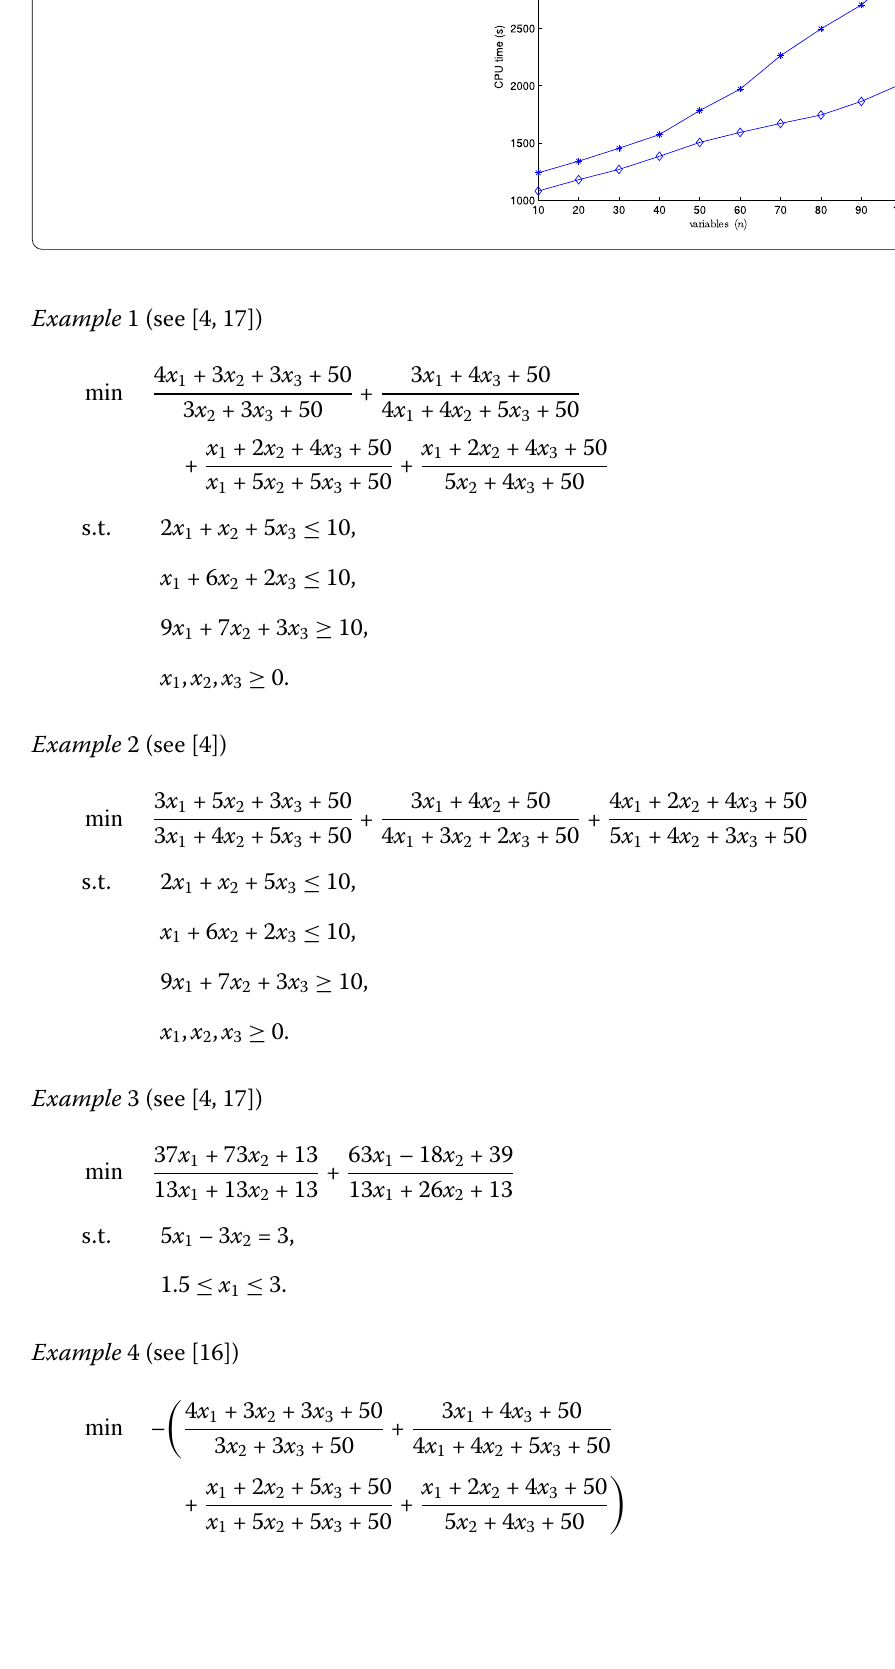
Figure 4 Average computational time in seconds when N = 50 and ε =